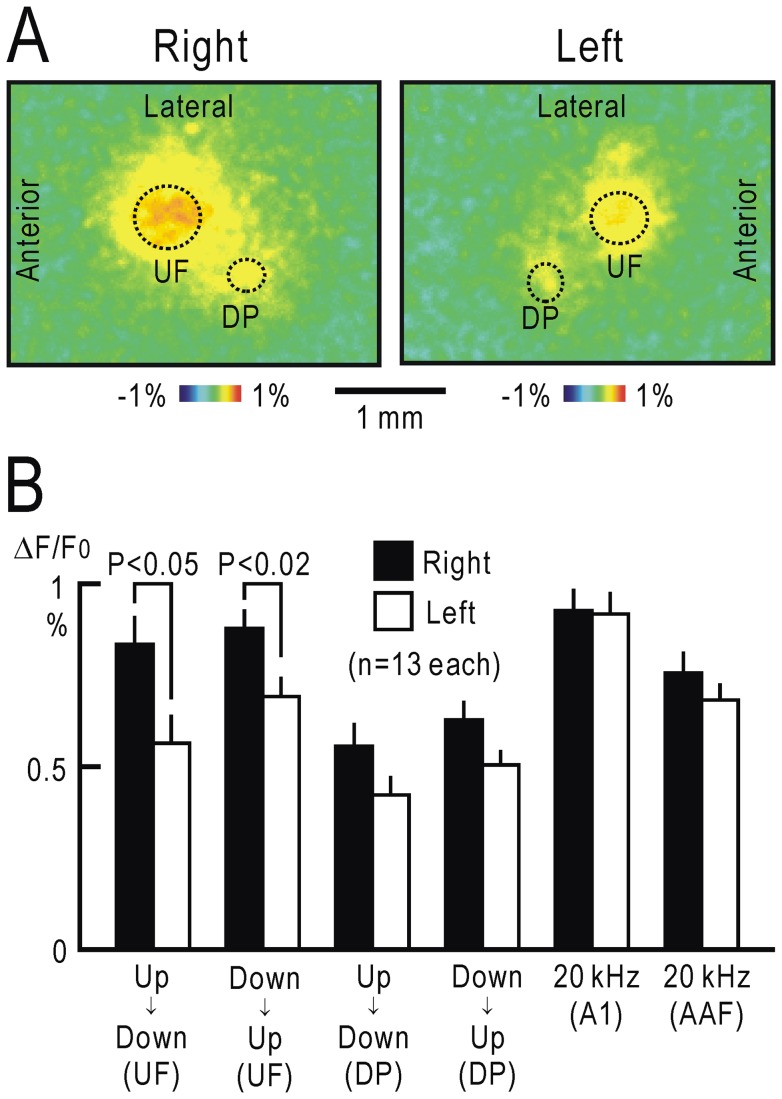
Comparison of responses to FM direction reversal between hemispheres.(A) Cortical responses to FM direction reversal from upward to downward in the right (left panel) and left (right panel) hemispheres. The responding areas that approximately corresponded to UF and DP are marked with dotted lines to show the symmetrical relation between both hemispheres. (B) Response amplitudes to FM direction reversal in UF and DP of both hemispheres. Response amplitudes to a 20 kHz AM sound in A1 and AAF of both hemispheres are also shown. Mean and S.E.M were obtained for 13 hemispheres for each. Significant differences between hemispheres were found only regarding the UF responses to FM direction reversal from upward to downward (P<0.05), and downward to upward (P<0.02).